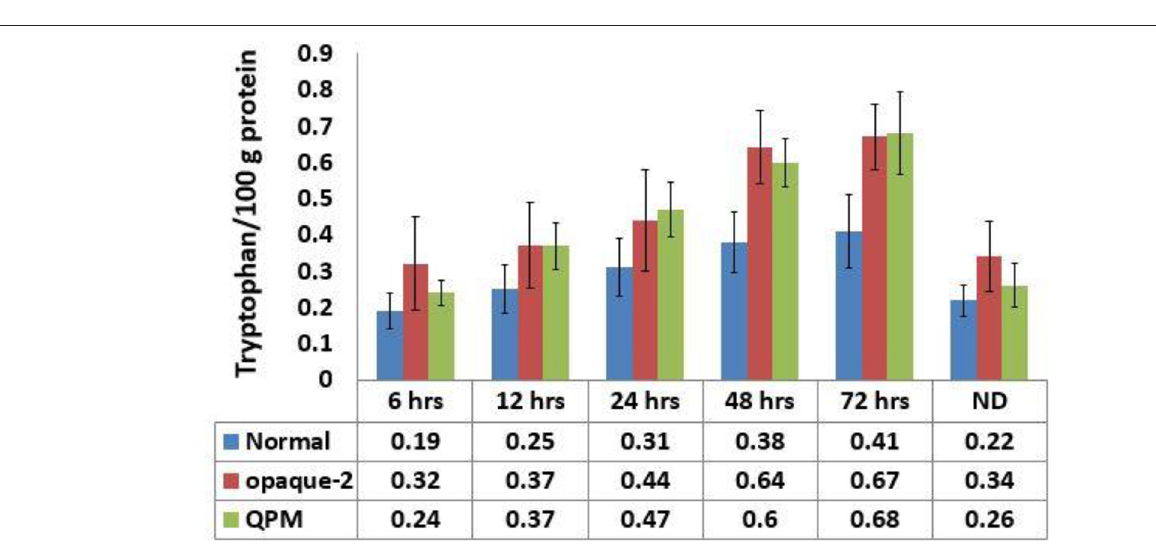
FIGURE 3 | Comparative tryptophan content in the experimental genotypes estimated at different defatting time. Error bars denote overall ± SD of the genotypes at particular time interval. The difference between the tryptophan content (%) among all experimental lines at different defatting time was significant at P ≤ 0.05. ND, non-defatted